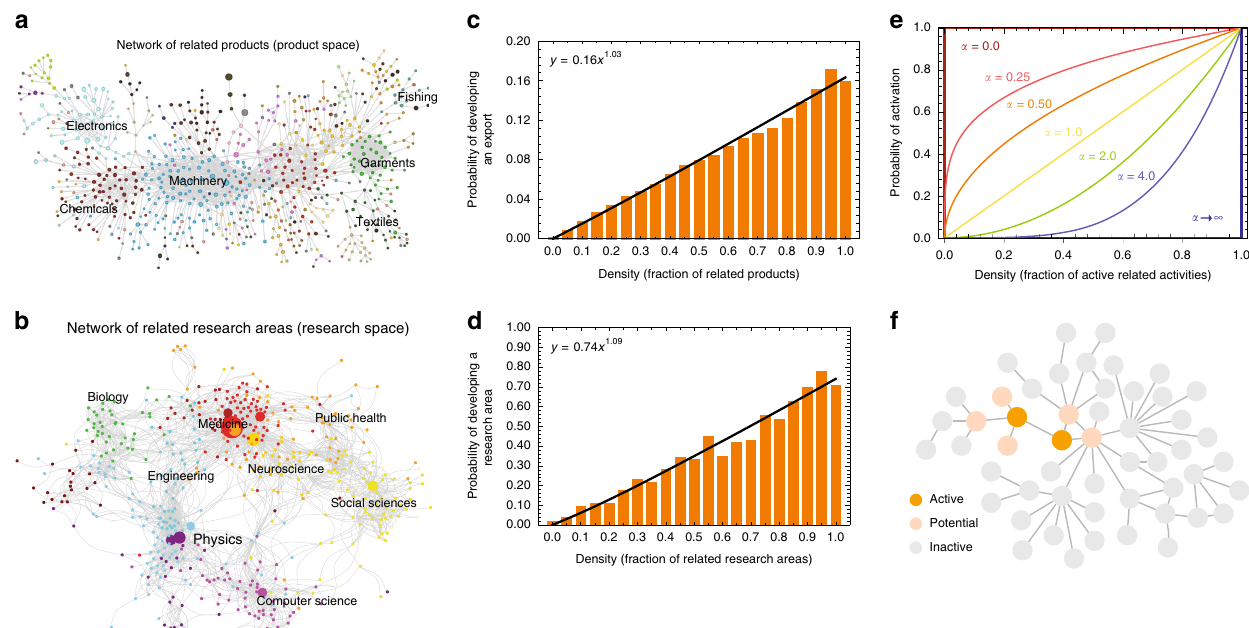
Fig. 1 Modeling the empirical development of exports and research areas. a Network of related products or product space (from ref. 1 ). b Network of related research areas or research space (from ref. 7 ). c Probability that a country ’ s export per capita in a product surpasses 25% of the world ’ s average as a function of density: the fraction of related products already exported by that country. d probability that the number of per capita publications of a country in a research area becomes larger than the world ’ s average as a function of density: the fraction of related areas where that country already participates in e . We model the behavior observed in c and e by using a power-function for the probability that an activity will be developed by a location (Eq. 1). Here we show the behavior of this power function for different values of α . f We model diffusion by assuming nodes in a network can be in three possible states: inactive (gray), potentially active (peach), and active (orange). Potentially active nodes are connected to active nodes but are not yet